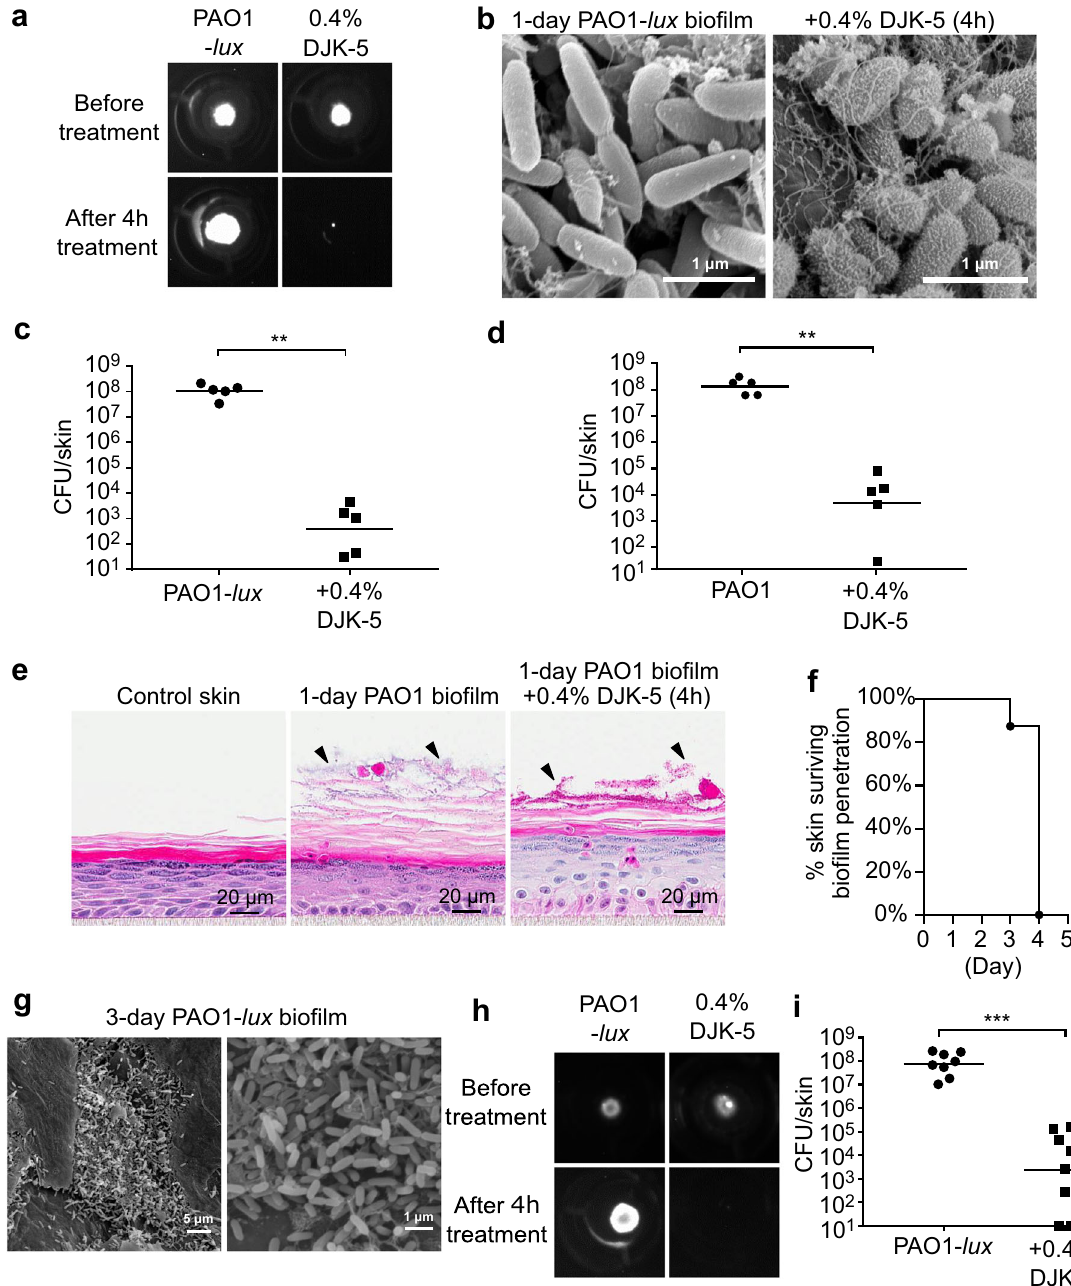
Fig. 3 DJK5-peptide diminished P. aeruginosa PAO1 1-day and 3-day skin bio fi lm. Bio fi lms of PAO1 or its luminescent version (PAO1- lux ) were seeded on the skin for 24 h then treated with 0.4% (120 µg) DJK5 peptide for 4 h. Luminescence signals from colonized PAO1- lux were imagined using the ChemiDoc Imaging System ( a ). Bio fi lm structures were visualized by SEM ( b ). Colony counts from skin samples infected with the luminescent ( c ) and non-luminescent ( d ) PAO1 were determined. Histological analysis of the bio fi lm structures was performed by H&E staining ( e ). The number of days that skin barrier withstood bio fi lm growth was monitored (raw data are shown in Supplementary Figure 1b) ( f ). PAO1- lux 3-day bio fi lm was imaged by SEM ( g ) and treated with 0.4% DJK-5 for 4 h, which reduced luminescence signals ( h ) and colony count ( i ). Statistical signi fi cance (** P ≤ 0.01; *** P ≤ 0.001) was determined using the Mann – Whitney test ( c , d , i ). Geometric mean of CFU count from 5 to 8 biological replicates as indicated in ( c , d , i cells were observed (Fig. 3g). DJK-5 demonstrated a comparable N/TERT skin bio fi lm model as a versatile platform for screening peptide activity antibio fi lm ef fi cacy on 3-day PAO1- lux bio fi lm, where peptide treatment wiped out luminescence signal after 4 h (Fig. 3h) and The one-day MRSA- lux (Fig. 4a) and PAO1- lux (Fig. 4b) skin bio fi lm signi fi cantly decreased bacterial burden (Fig. 3i). Again no system was used to screen the activity of several synthetic signi fi cant changes in toxicity and immune responses were HDPs (sequences listed in Supplementary Table 1) at a peptide triggered by PAO1- lux bio fi lms by day 3 (Supplementary Fig 3d-f). concentration of 0.1%. This approach revealed differential